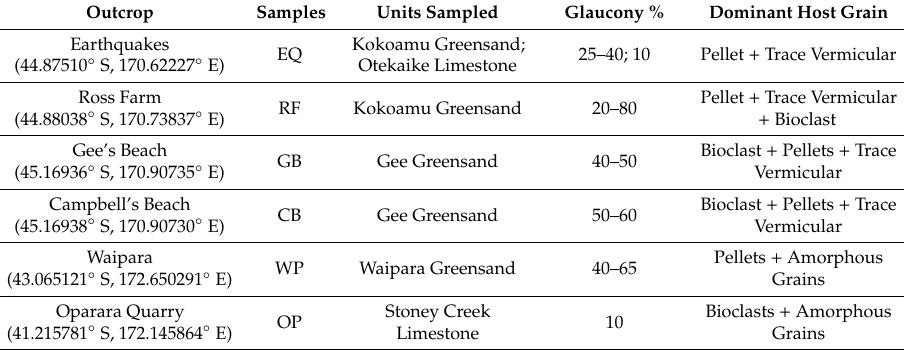
Table 1. Summary of outcrops and units sampled for geochemical analysis with glaucony % of bulk sediment by volume and dominant host material